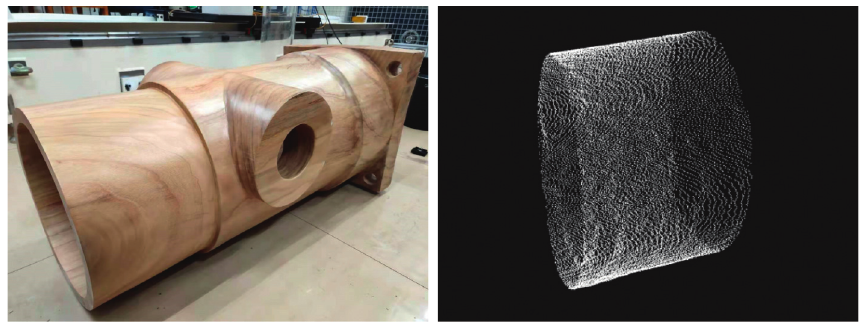
Figure 8: Cylindrical surface